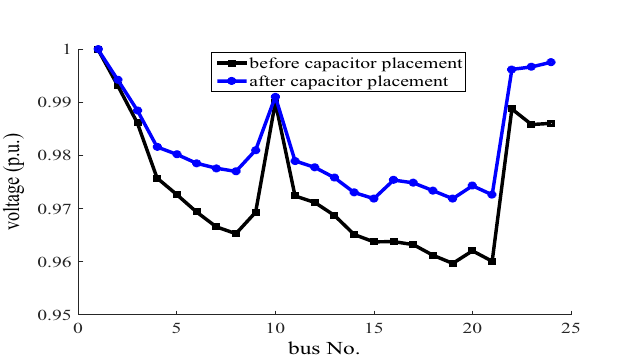
Figure 5. Voltage profile of 24-bus network in the grid-connected mode for the heavy load before and after capacitor placement, with cosφ#1.